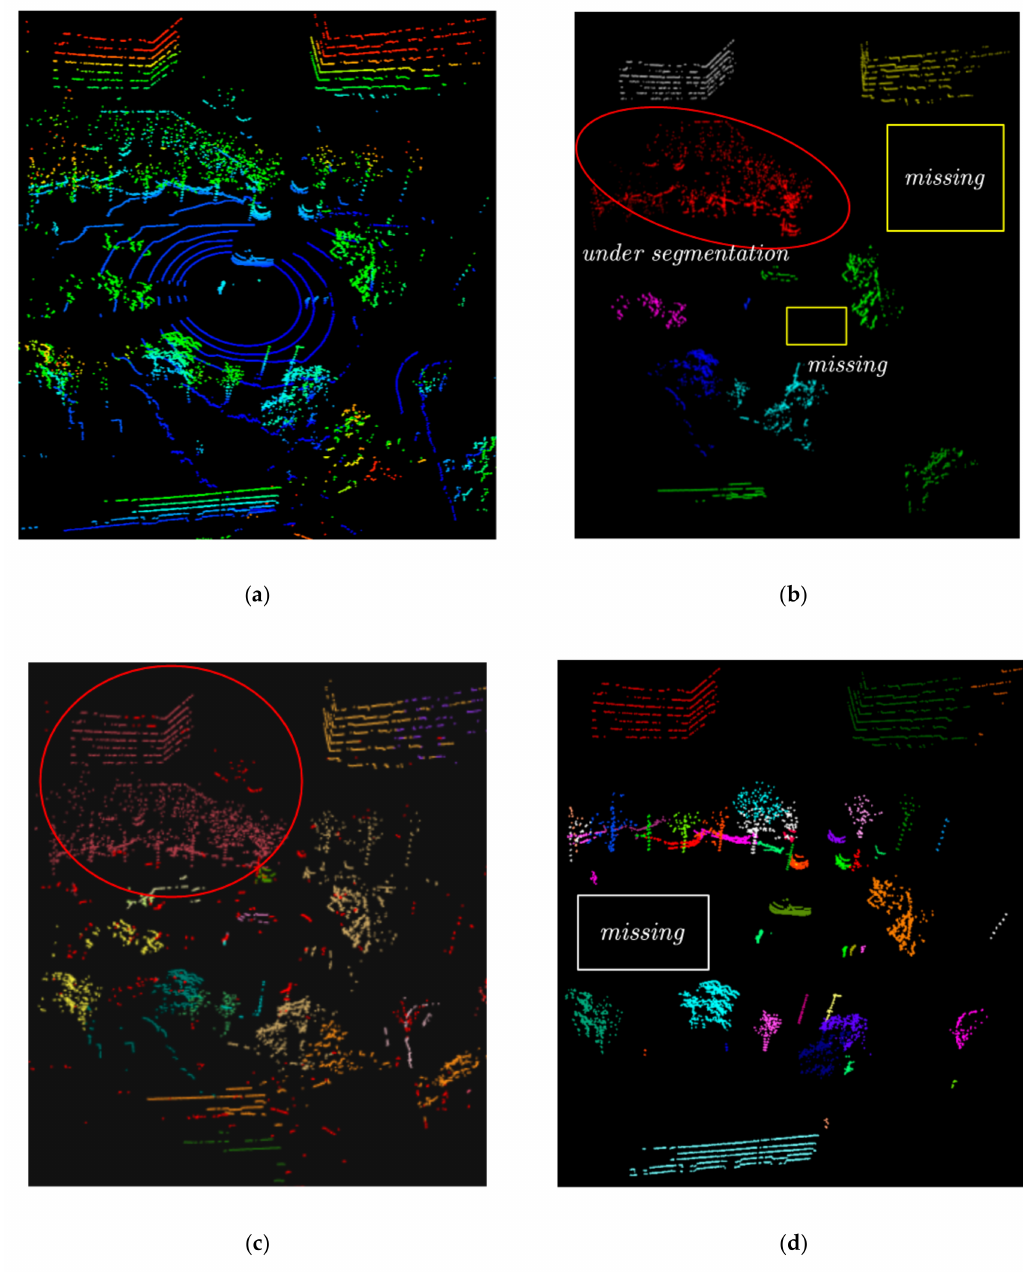
Figure 20. The results of di ff erent segmentation algorithms on an example point cloud are shown in LiDAR 360 software. Di ff erent colors in the original point cloud mean di ff erent heights. Di ff erent colors in the segmentation result mean di ff erent objects. ( a ) The raw point cloud before segmentation; ( b ) The results of instance segmentation by a Euclidean-based segmentation; ( c ) The results of instance segmentation by the regional growth algorithm in the Point Cloud Library (PCL); ( d ) The results of instance segmentation by the proposed